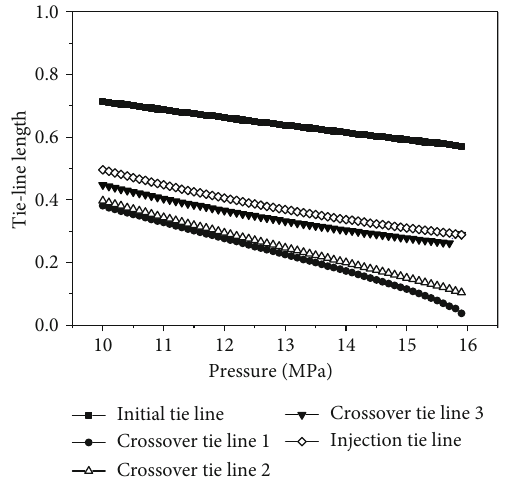
Figure 7: Variation of key tie-line lengths vs. pressure for Case 2. The MMP was estimated to 16.02 MPa